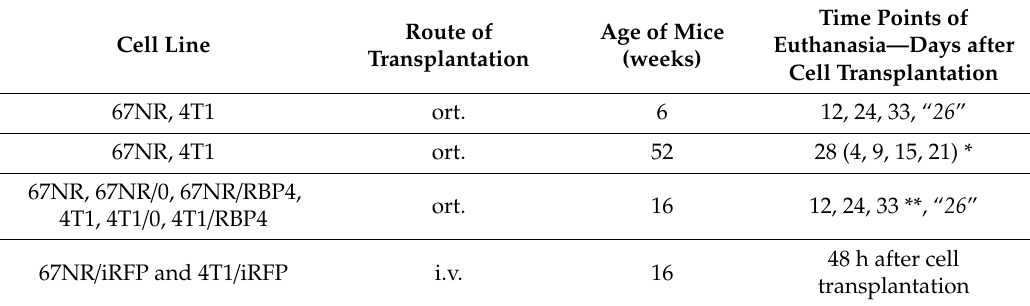
Table 1. Detailed characteristics of animal